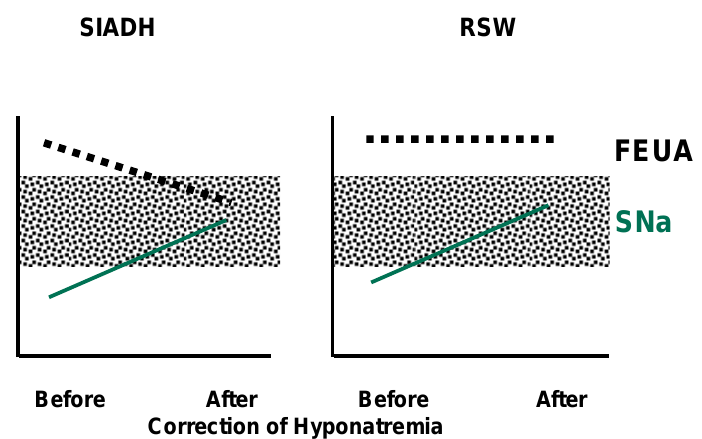
Figure 1. Changes in FEurate in SIADH and RSW after correction of hyponatremia. Shaded areas represent normal ranges. (Maesaka J. K., modified from